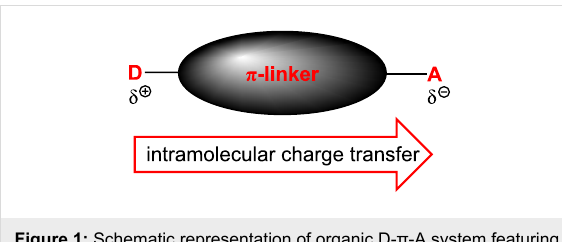
Figure 1: Schematic representation of organic D- π -A system featuring ICT.